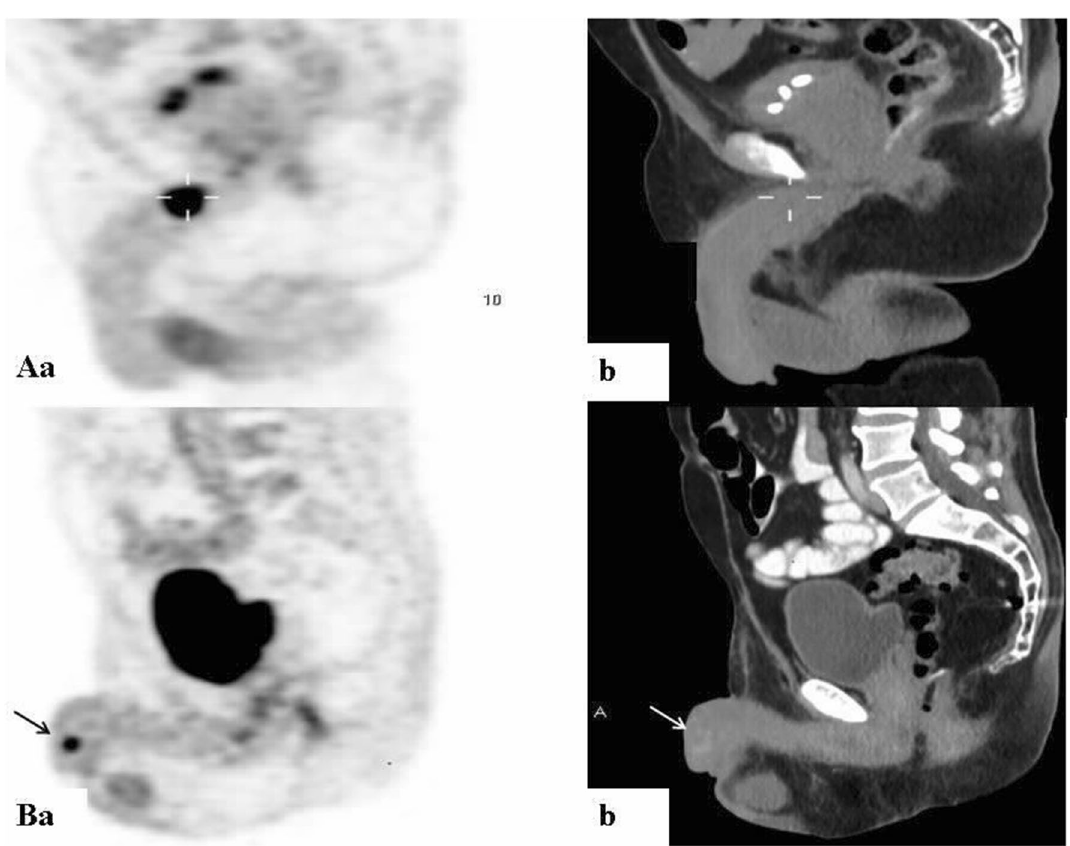
Figure 3. 18F-FDG scans demonstrating focally increased uptake at different places along the penis on PET ( a ) and CT ( b ) sagittal slices. ( A ) An 84-year-old man with metastatic high-grade urothelial carcinoma (patient